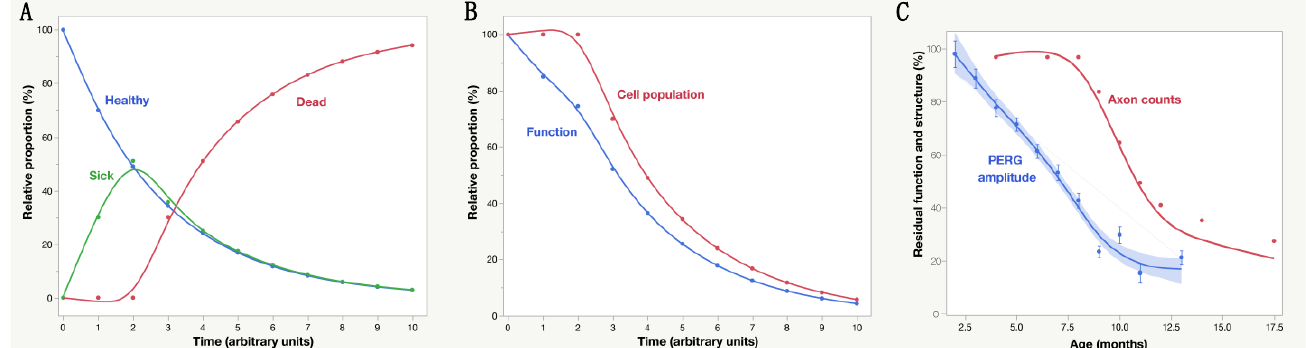
Figure 2. ( A ) Model of progressive optic neuropathy in which a given proportion (30%) of healthy RGCs become sick at time 1 and survive until time 2, with the process repeating at each successive time unit. ( B ) Assuming that sick RGCs function at 50% of normal capacity, the overall RGC function as measured by PERG decreases exponentially over time, anticipating a similar decay of the mean inner retinal thickness as measured by OCT. ( C ) Natural history of PERG amplitude and optic nerve axon counts in DBA/2J mouse glaucoma. PERG data are replotted from Saleh et al., 2007, and represent the mean ± SEM of 32 mice; average axon counts are derived from Libby et al. 2005 and Anderson et al. 2005. The shaded area represents the 95% confidence interval of the spline regression curve interpolating PERG data.